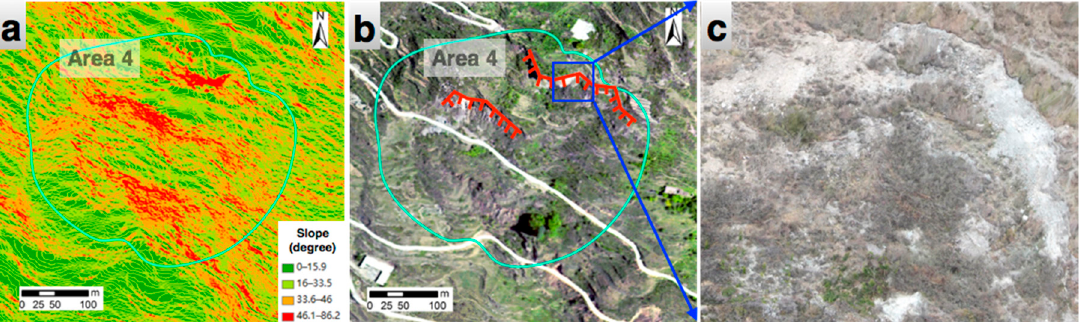
Figure 7. ( a ) The slope information of a rotational slide developed in the middle part of the Xishancun Landslide. Its location could be referred to Area 4 in Figure 2. ( b ) The rotational slide with a main scarp and a minor scarp both clearly visible in the DEM. ( c ) The enlarged view of the trailing edge earmarked by the rectangle in ( b ) from high-resolution ortho-images.